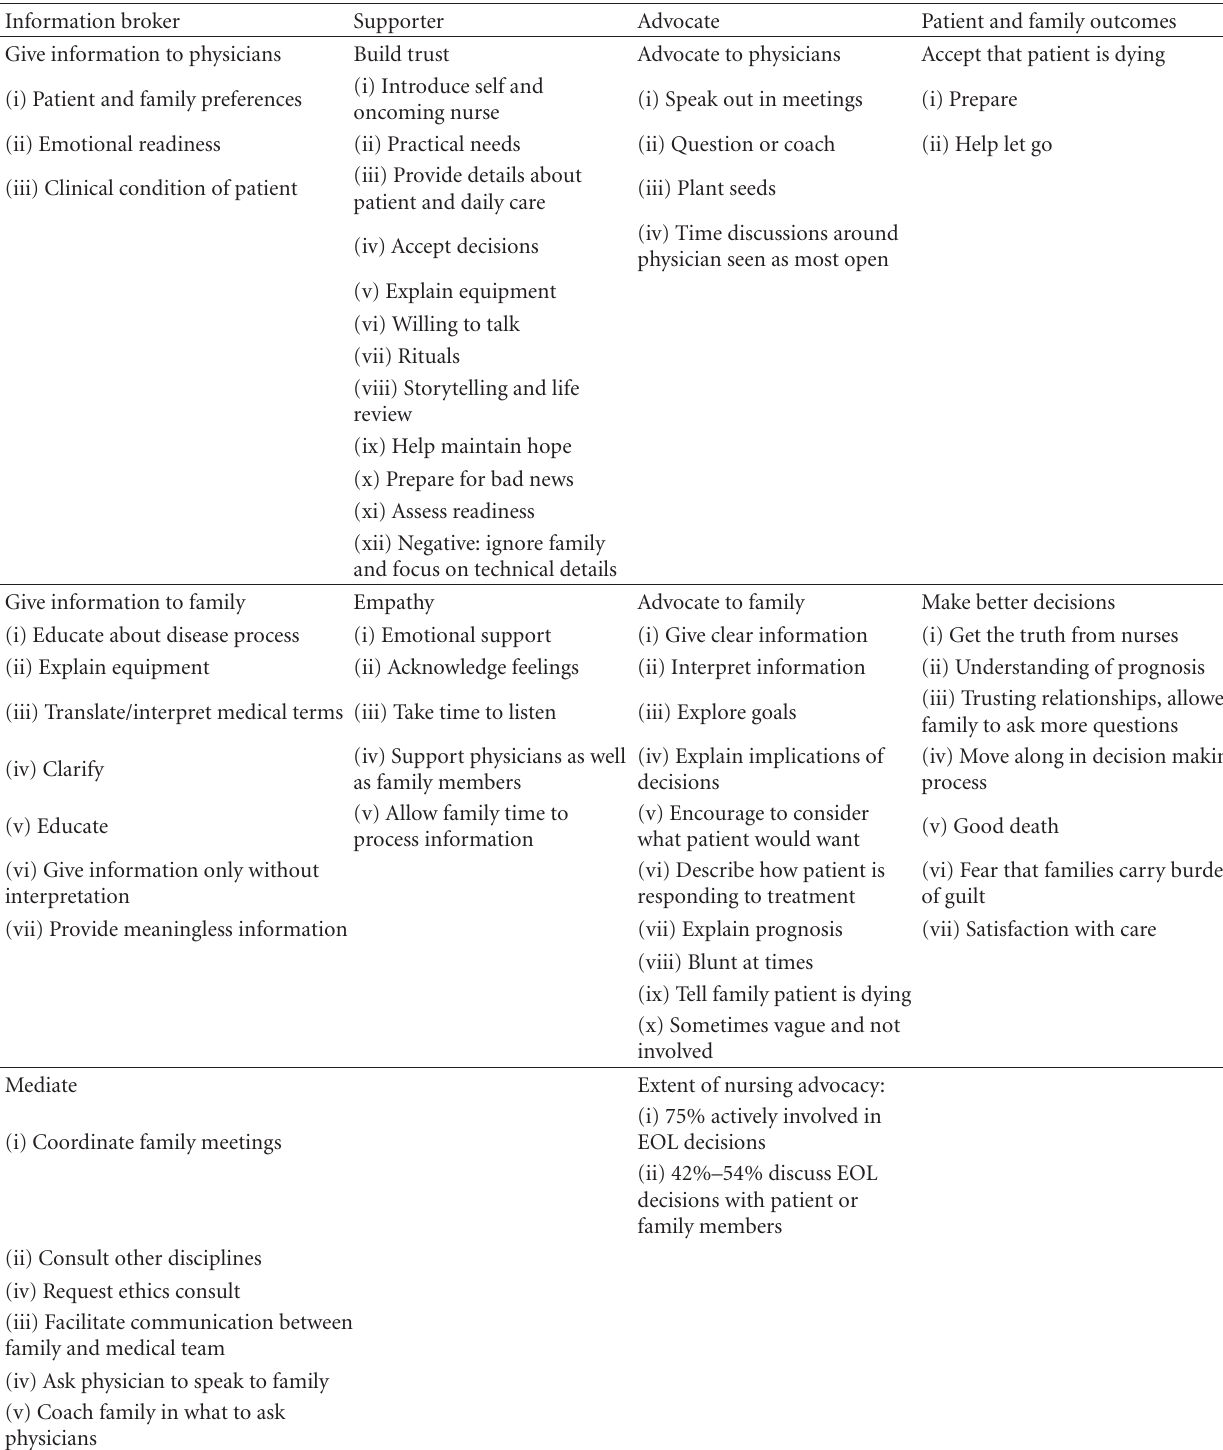
Table 2: Summary of roles, strategies, and